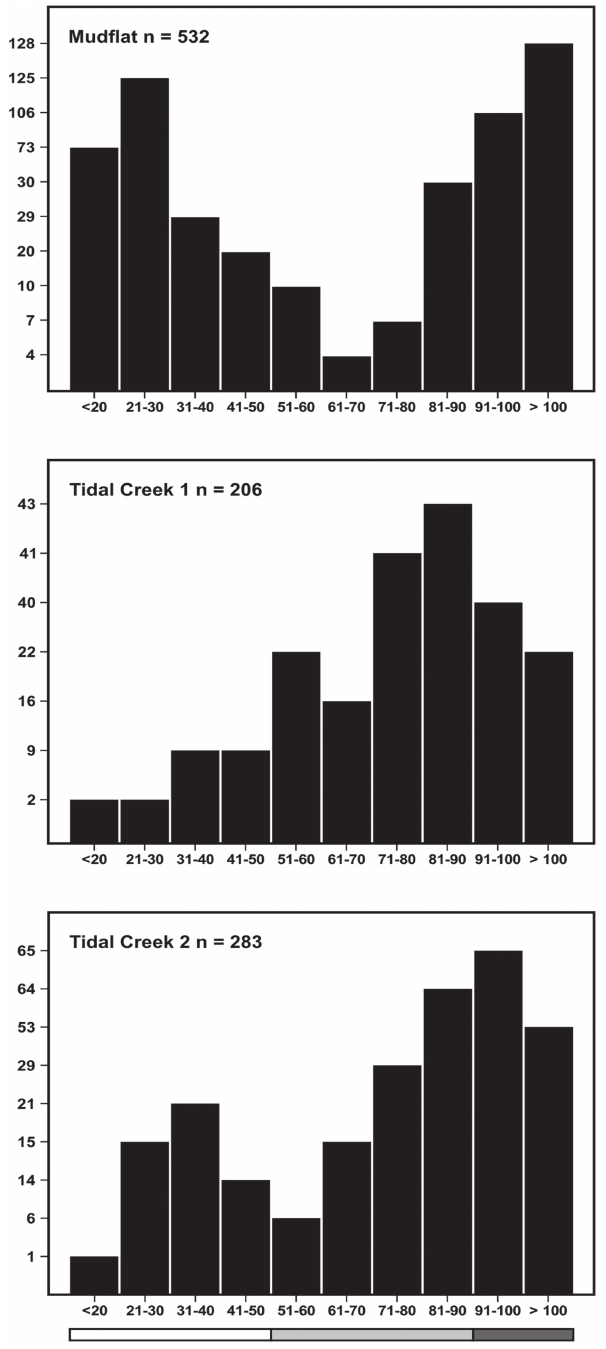
Fig. 4 . Volumetric Percentage (%V) per habitat ( a ) of the most important food items in the diet each size classes (TL = 1 small juveniles; TL = juveniles and TL = adults) of the 2 3 Mamanguape river estuary, northeastern Brazil. ( b : Mudflat, c : Tidal Creek 1 and d : Tidal Creek 2).